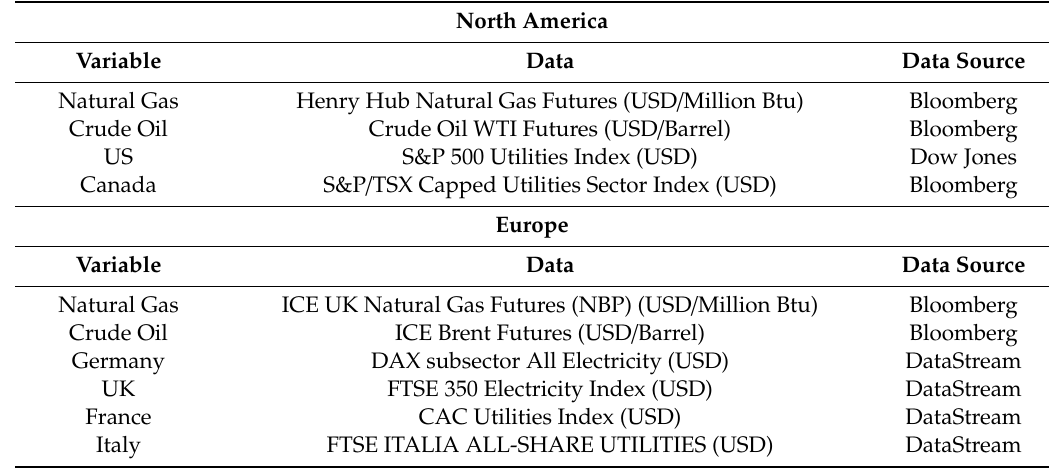
Table 1. Variables in the